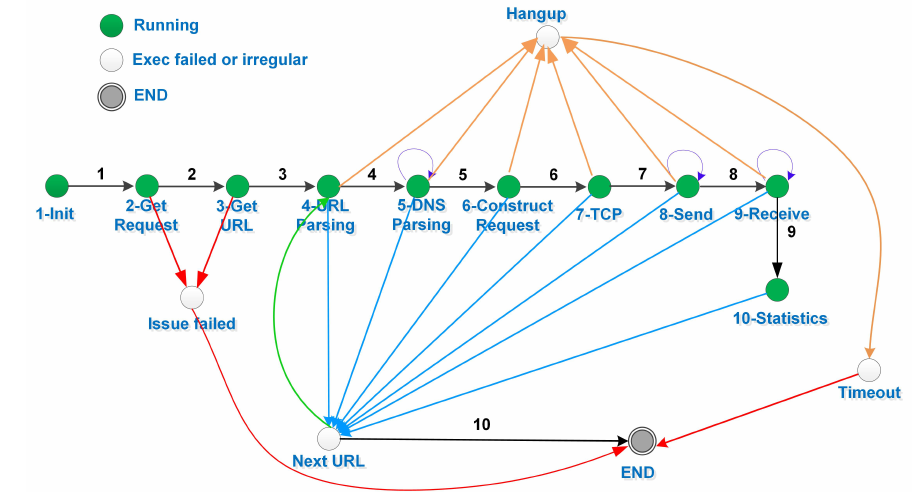
Figure 7. The global state